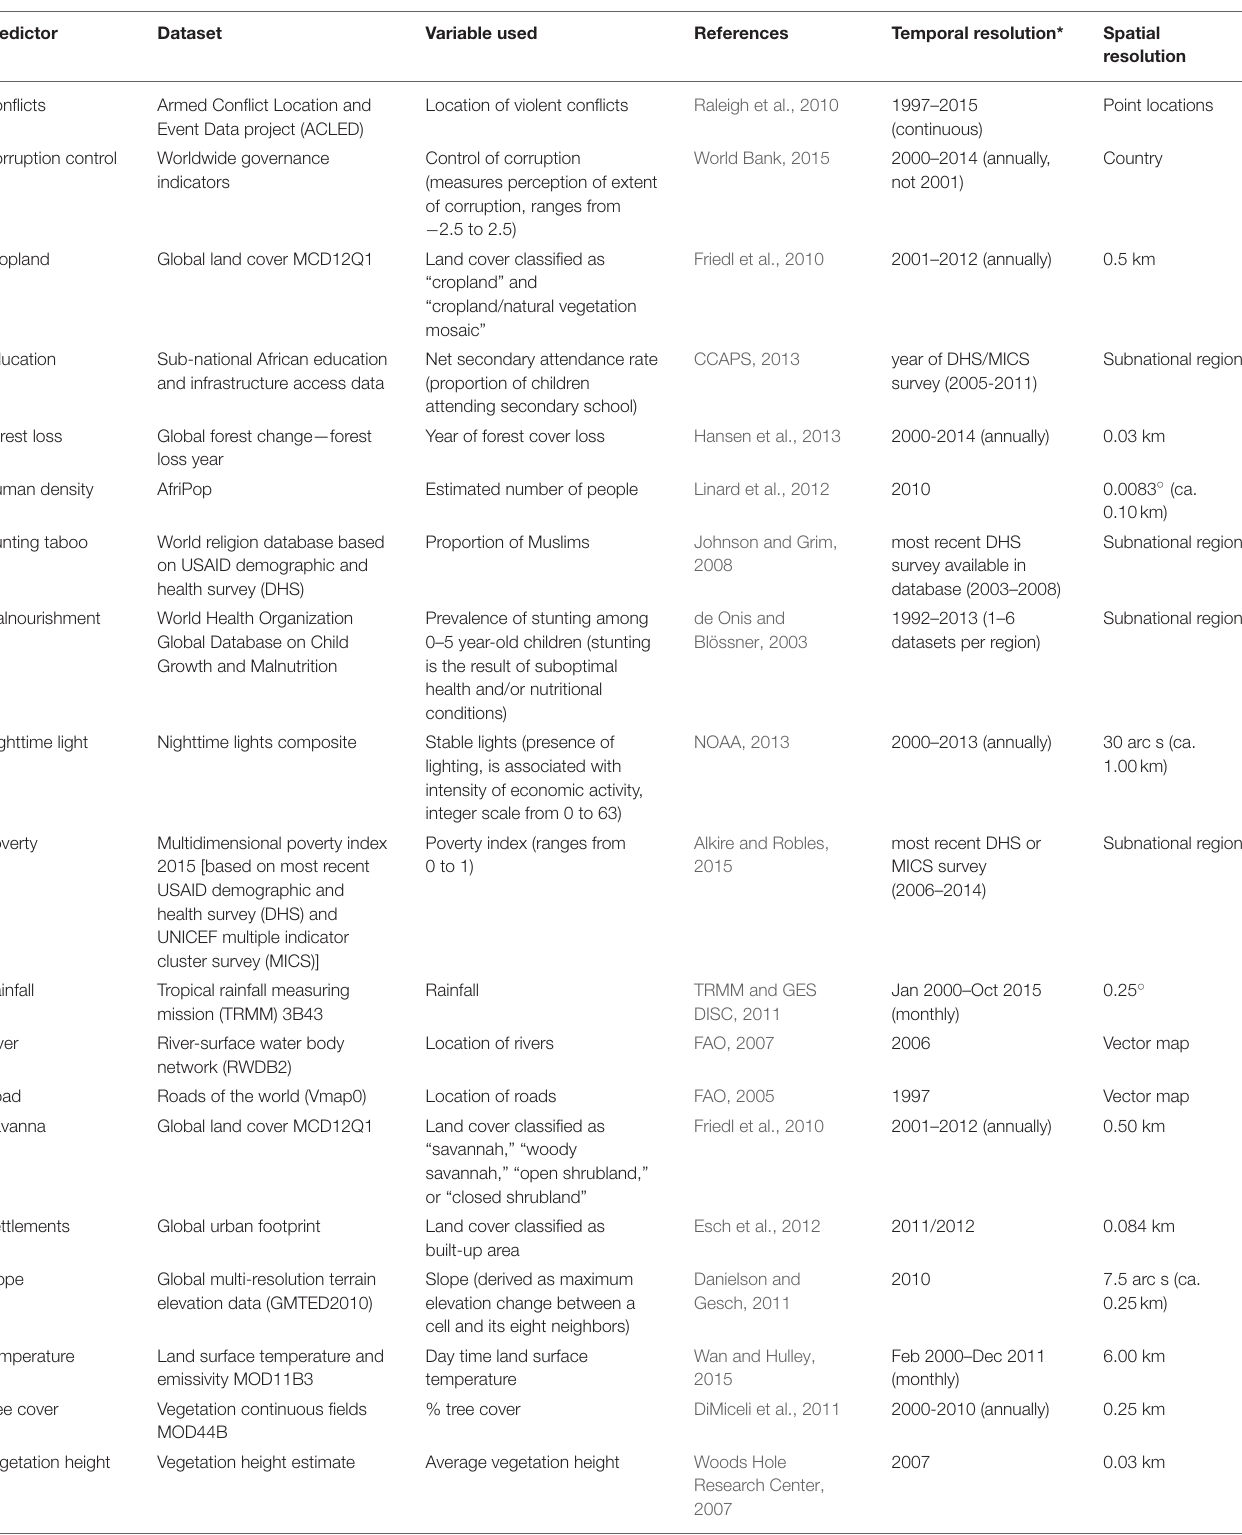
TABLE 1 | Dataset sources for predictors in the statistical